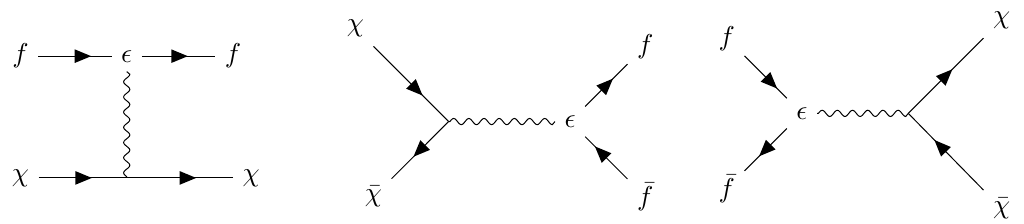
Figure 1. Relevant Feynman diagrams for SM-DM interactions: elastic scattering (left), s -channel annihilation of DM to SM (middle), s -channel production of DM from SM (right).